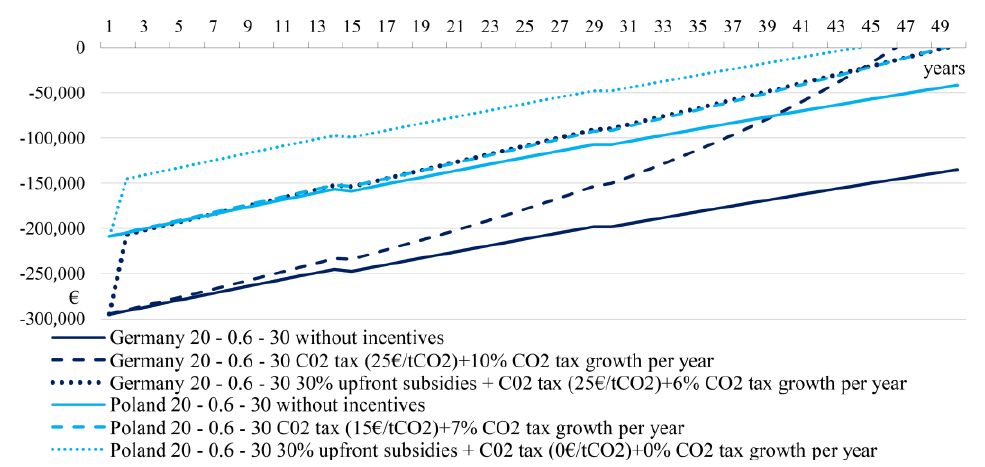
Figure 10. The combination of the incentives that could result in an NPV cost-effective period of 50 years (d = 3.5%, energy price rise 3% per year) for the optimal NG scenarios for Germany and Poland.